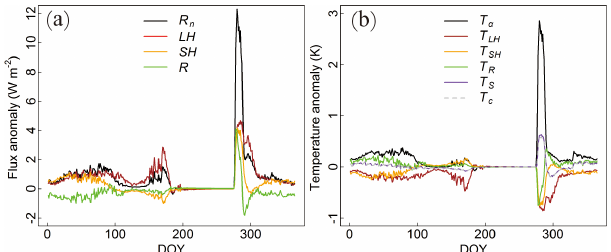
Figure 4. (a) The differences in the surface fluxes between the sow- ing scenarios of EP and LP. (b) Its contributions to T c